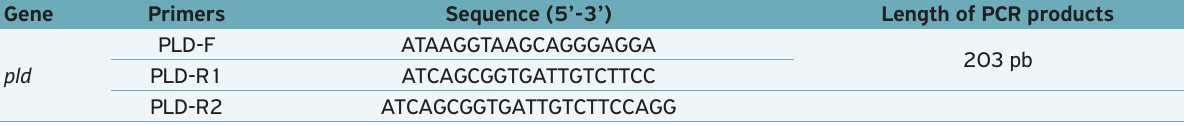
Table 1. Sequence of oligonucleotide primers for C. pseudotuberculosis detection adapted of Pacheco et al. (2007).